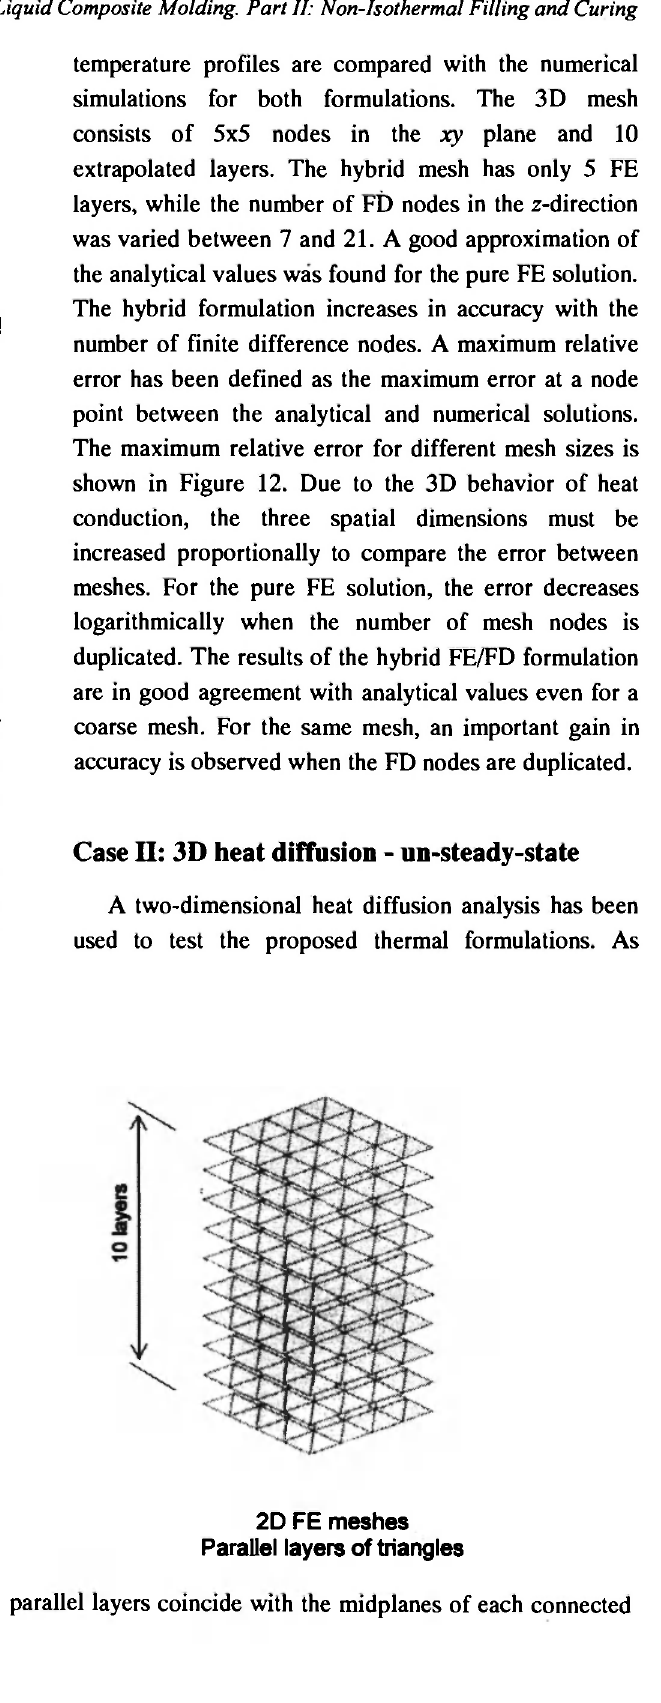
Fig. 10: Two meshes used for test case I: extrapolated parallel layers coincide with the midplanes of each connected